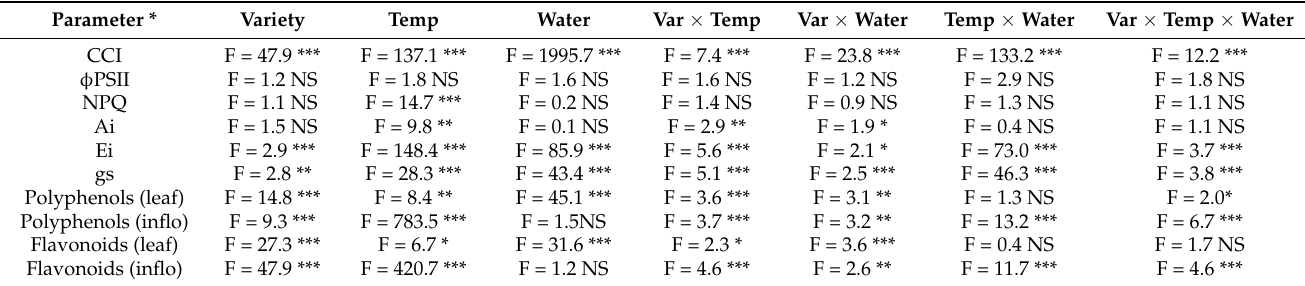
Table 3. Statistical results (ANOVA3) of physiological and antioxidant parameters of F. tataricum varieties subjected to two temperatures (21 ◦ C vs. 28 ◦ C) and water supply conditions (well-watered (WW) vs. water-stressed